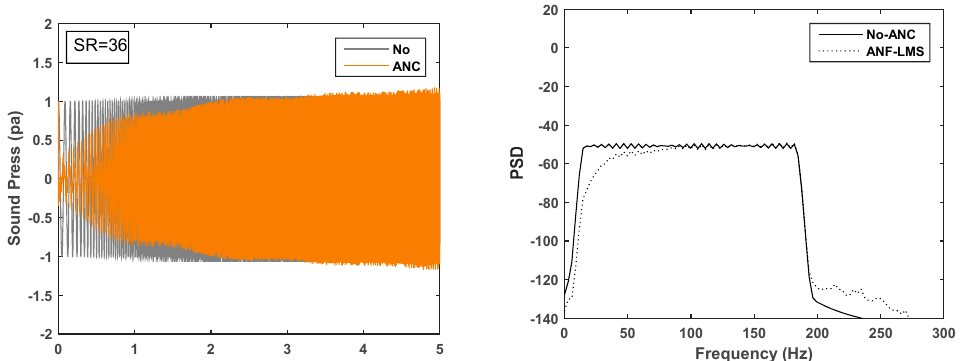
Figure 6. Time history and PSD of the signal 1 with different sweep rate controlled by the Leaky NLMS algorithm-based adaptive notch filter with two weights ( L = 2), leakage factor ( γ = 1), and step size μ = 2.